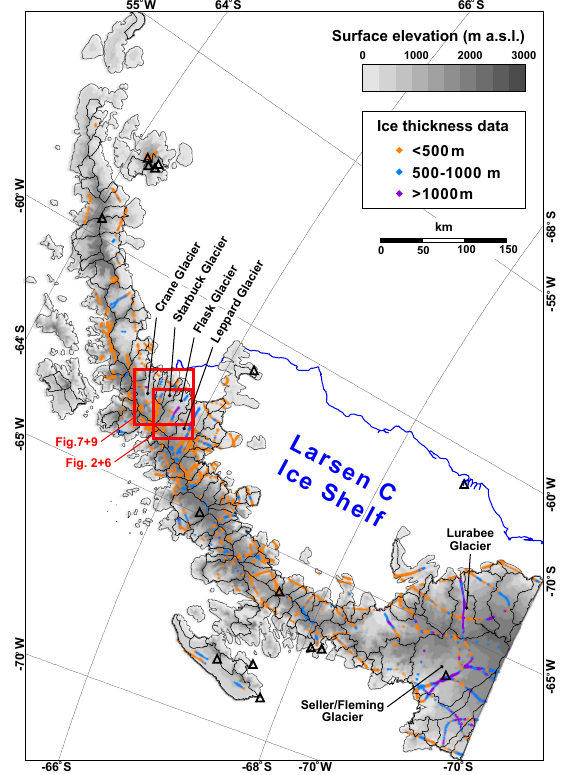
Figure 1. Antarctic Peninsula north of 70 ◦ S. Shading refers to sur- face topography. Outlines of flow catchments larger than 200km 2 according to Cook et al. (2014) are shown. Ice thickness mea- surements available from all Operation IceBridge campaigns 2002– 2012 are indicated by dots colour-coded to thickness classes. Trian- gles show surface mass balance observations (Turner et al., 2002). Ice shelf margins are drawn according to the SCAR Antarctic Digi- tal Database version 6.0. Red rectangles refer to detailed